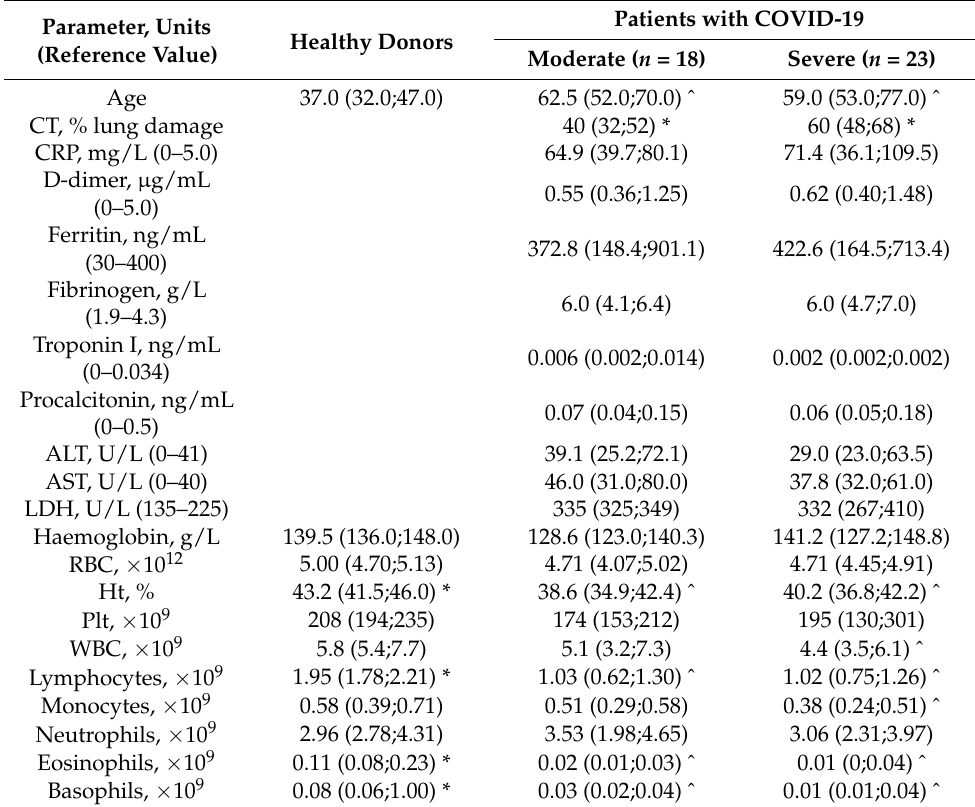
Table 2. Characteristics of healthy donors and patients with COVID-19, Me (25;75). Cut-off values are given for an appropriate